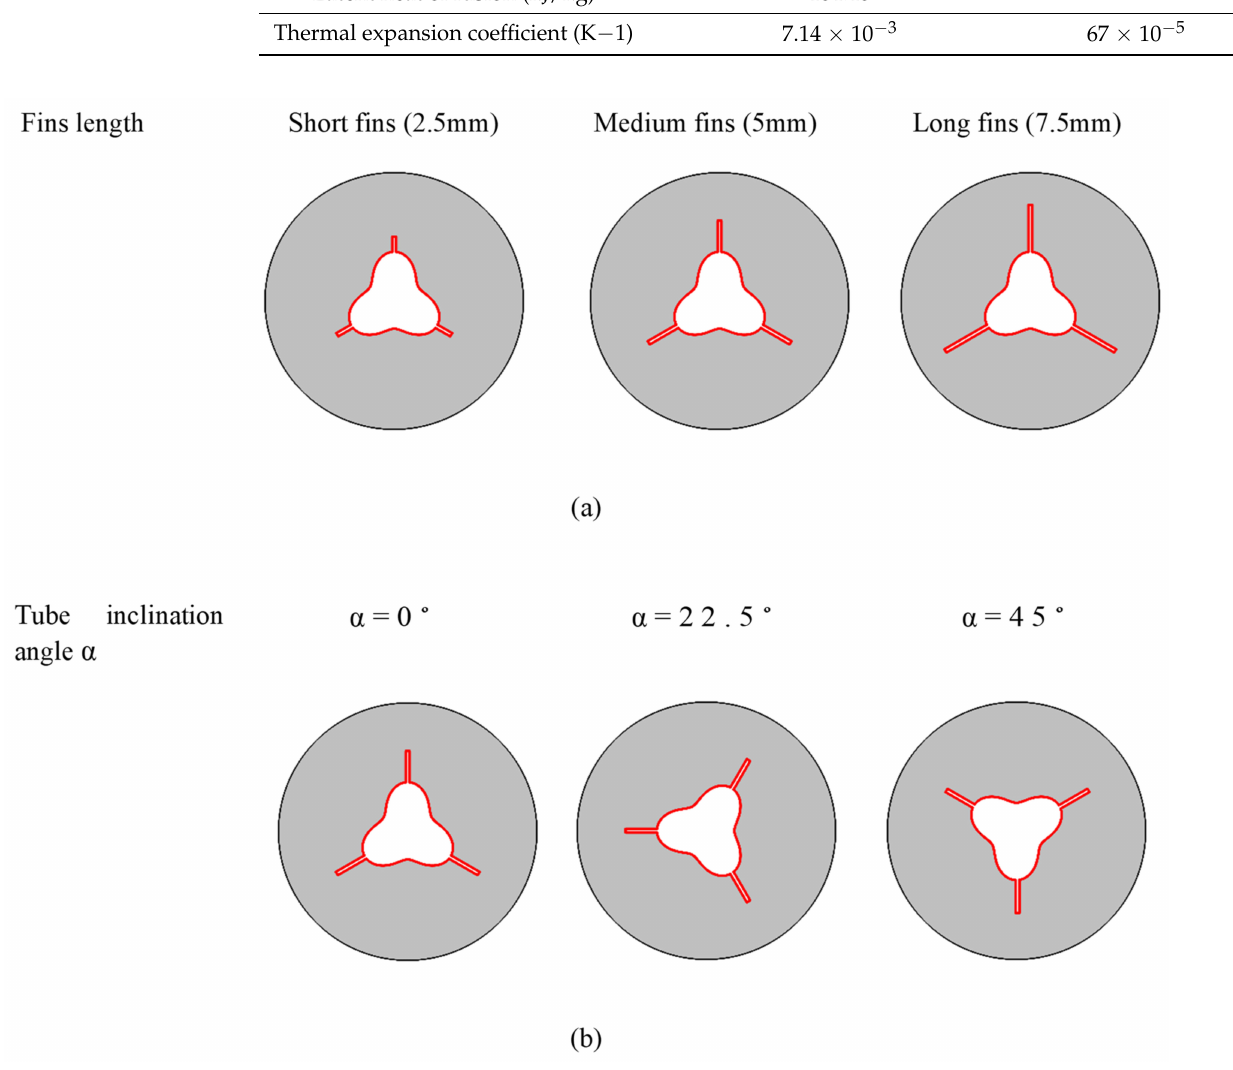
Figure 2. Introduction of the studied cases in the present article for ( a ) various fin lengths and for ( b ) various tube inclination angles α